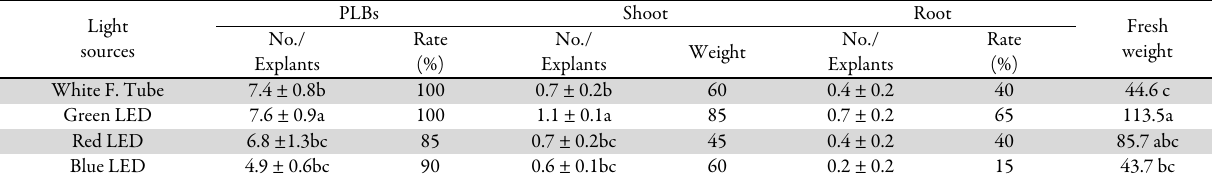
Table 3. In vitro culture of C. devonianum PLBs in modified MS medium supplemented with sucrose and trehalose (10 g L -1 + 10 g L -1 with modified MS medium) under different sources of lights